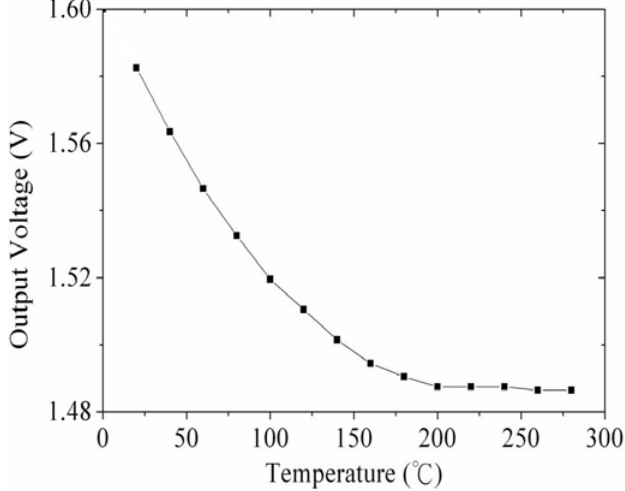
Figure 4. Relation between the output voltage and temperature for the